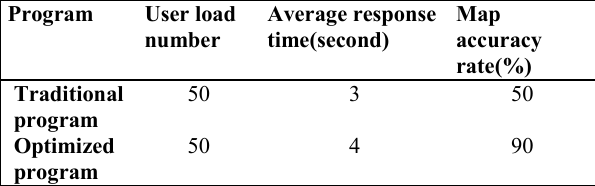
Table 2. Comparison of test results before and after map